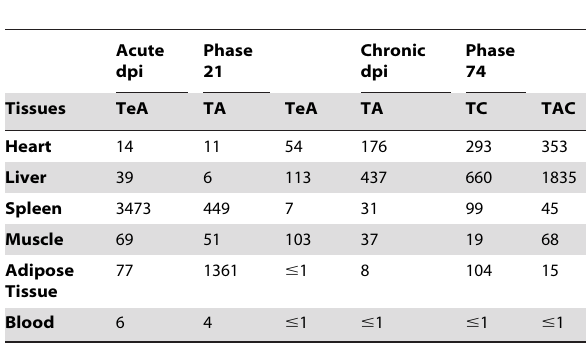
Table 2. Reductions of DNA parasite loads in organs of AmBisome-treated